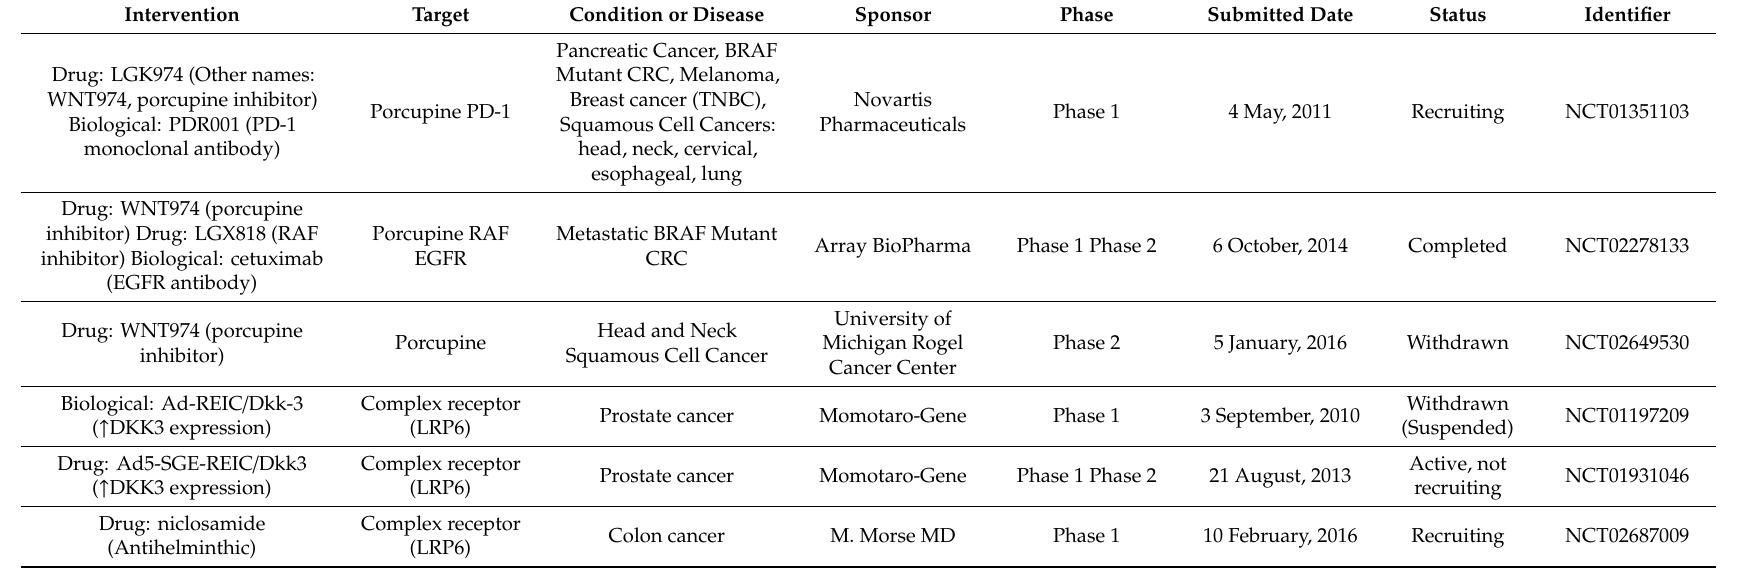
Table 3. Clinical trials targeting e ff ectors of WNT / β -catenin pathway. Given the importance of the WNT / β -catenin pathway in cancer development, e ff ectors of this pathway such as porcupine and LRP6 are specifically targeted in Phase 1 and 2 clinical trials in various cancers. Ad: adenovirus, DKK3: Dickkopf-related protein 3, RAF: rapidly accelerated fibrosarcoma, PD-1: Programmed cell death 1, EGFR: epidermal growth factor receptor.